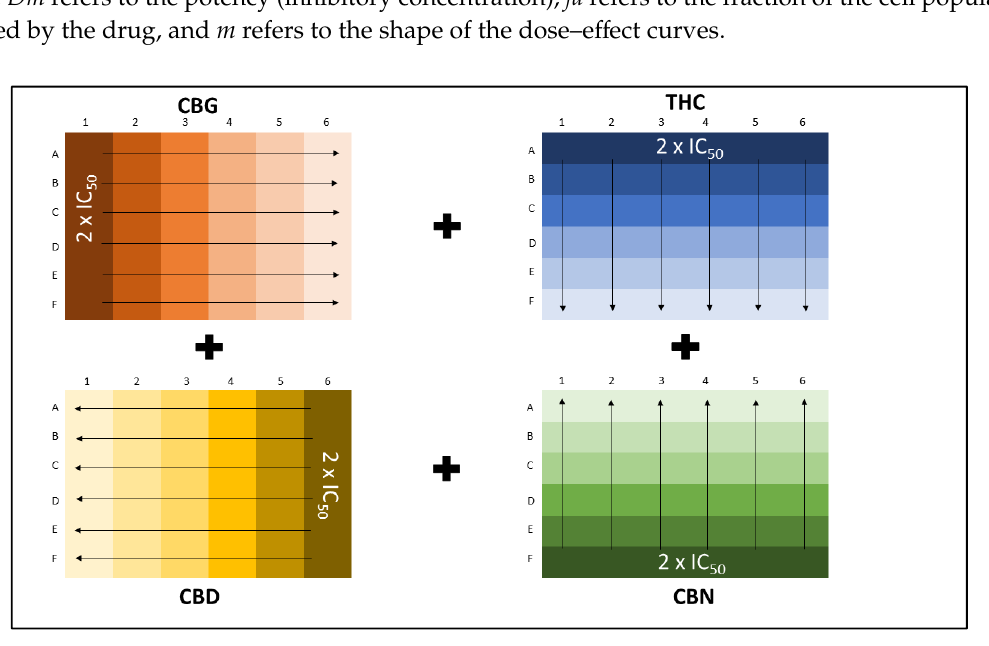
Figure 10. Illustration of the combination of four cannabinoids in a 96-well cell culture plate for the treatment of the breast cancer cell lines, MDA-MB-231 and MCF-7. Darkest color indicates the highest concentration, which was subsequently diluted in the direction illustrated.